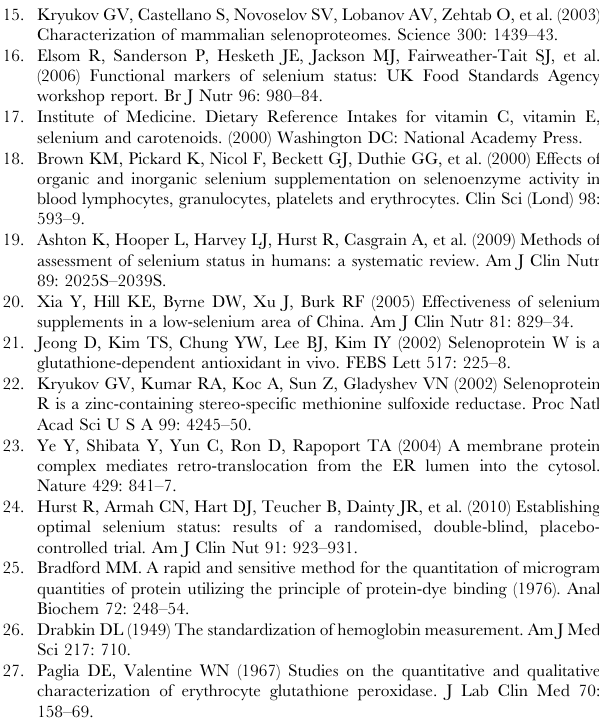
Figure S1 Flow diagram to represent the number of volunteers who were screened and recruited onto the study. Reproduced with permission by Hurst et al 2010